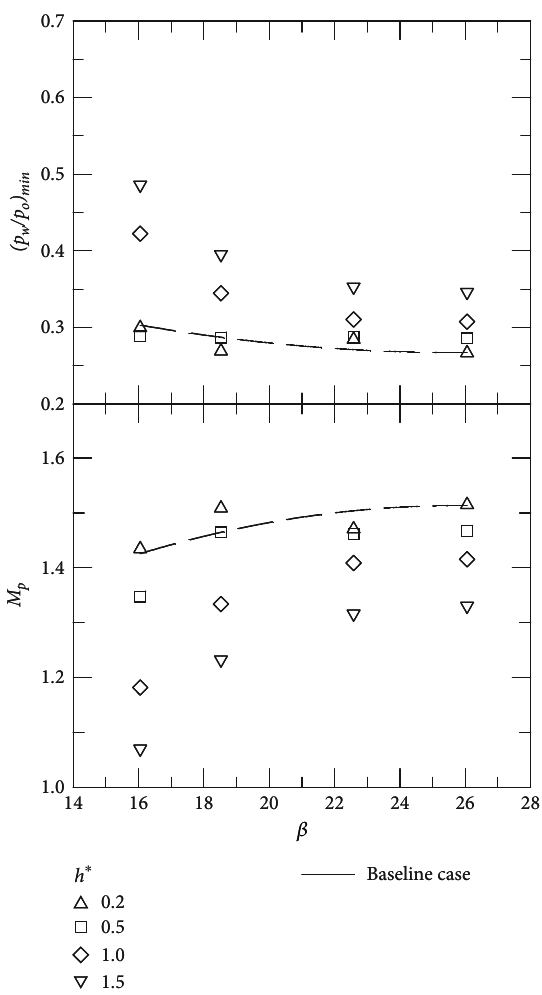
Figure 6: The e ff ect of VGs on fl ow expansion near the corner ’ s